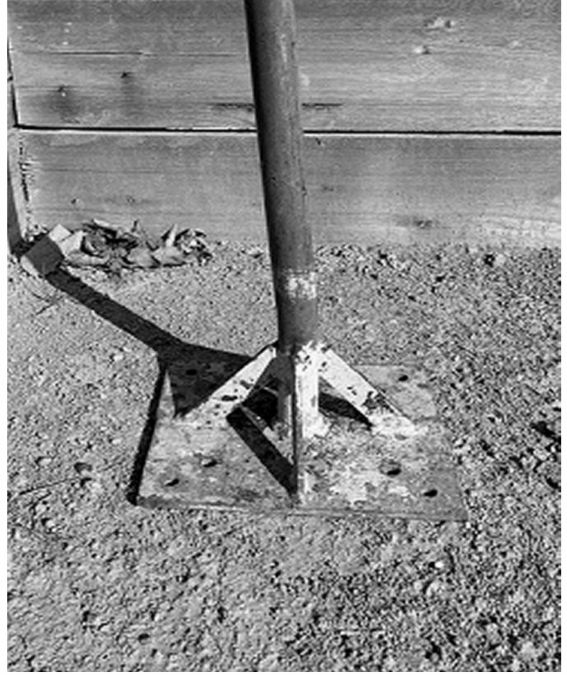
Figure 3. Image of the compaction tool with 4 kg mass dropped three times from a height of 0.30 m onto an area of 0.20 m × 0.17